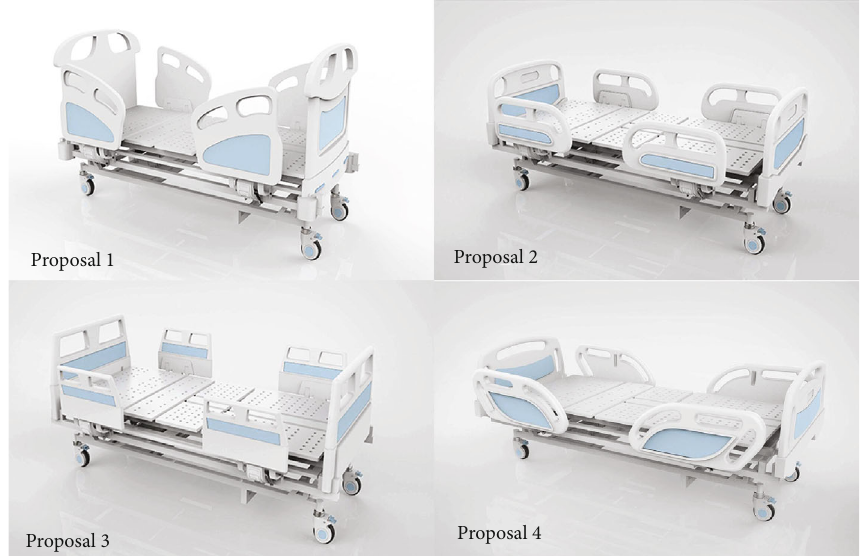
Figure 2: Four proposed nursing beds.